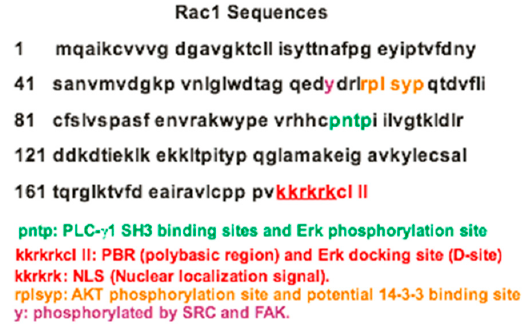
Figure 1. Rac1 sequences, motifs and phosphorylation sites.